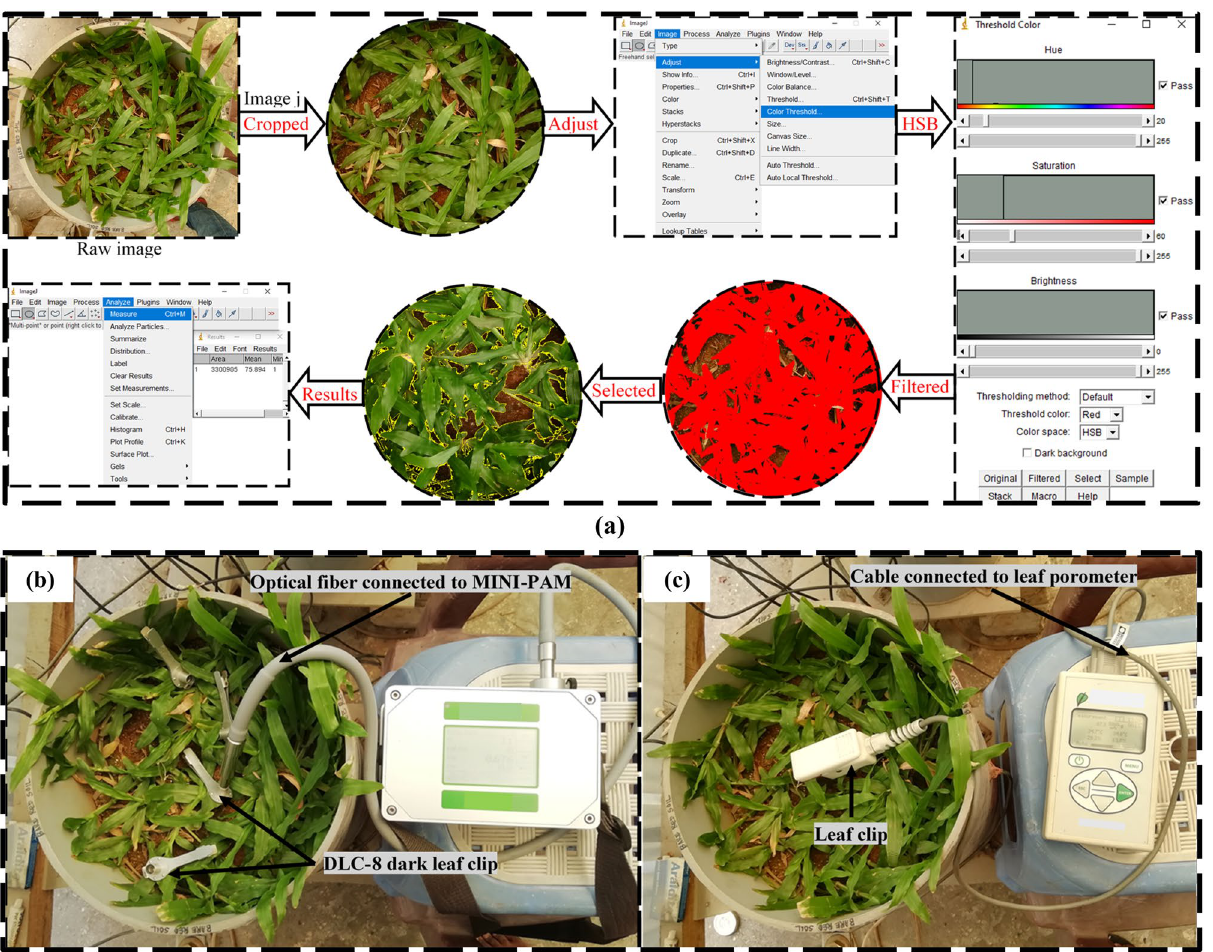
Figure 3. ( a ) steps for determining VD by image analysis technique and determination of, ( b ) photosynthetic yield and ( c ) stomatal